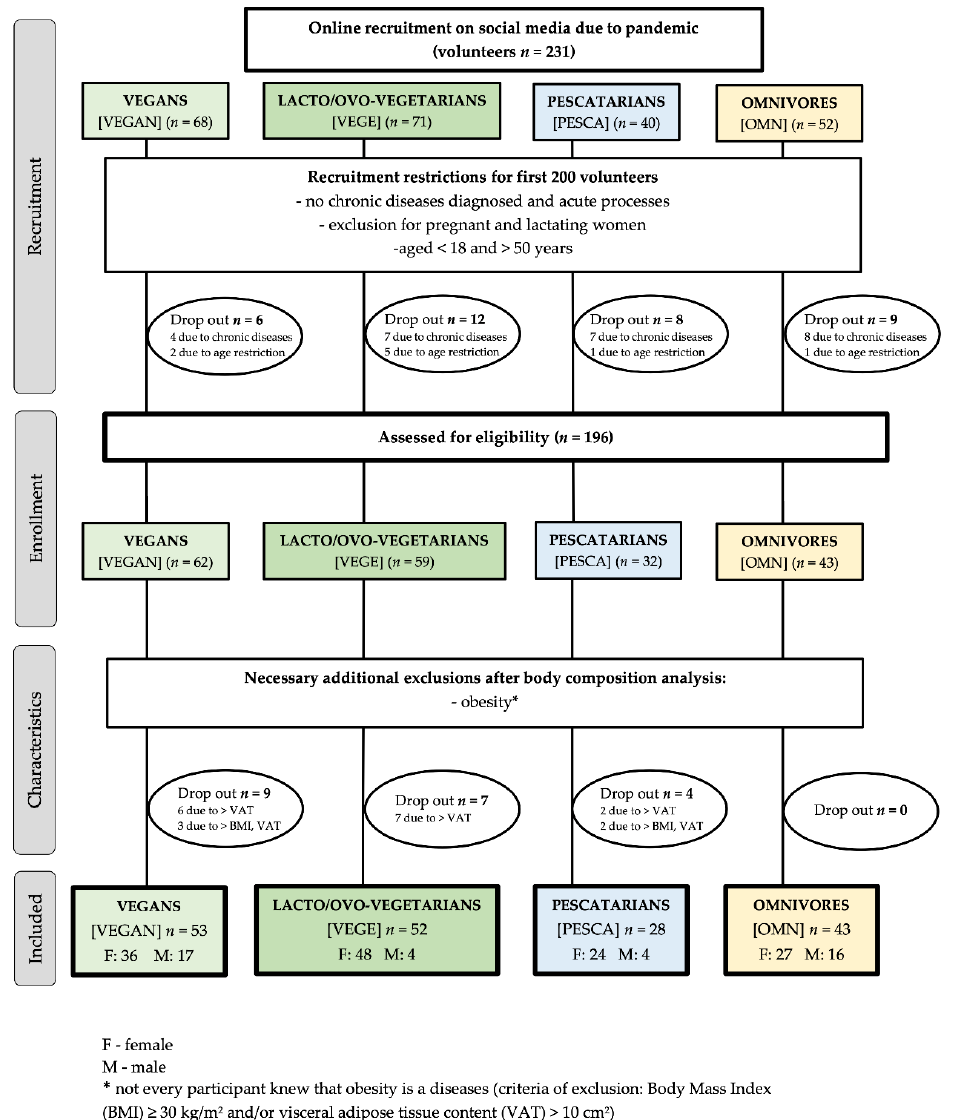
Figure 1. The scheme of recruiting participants.